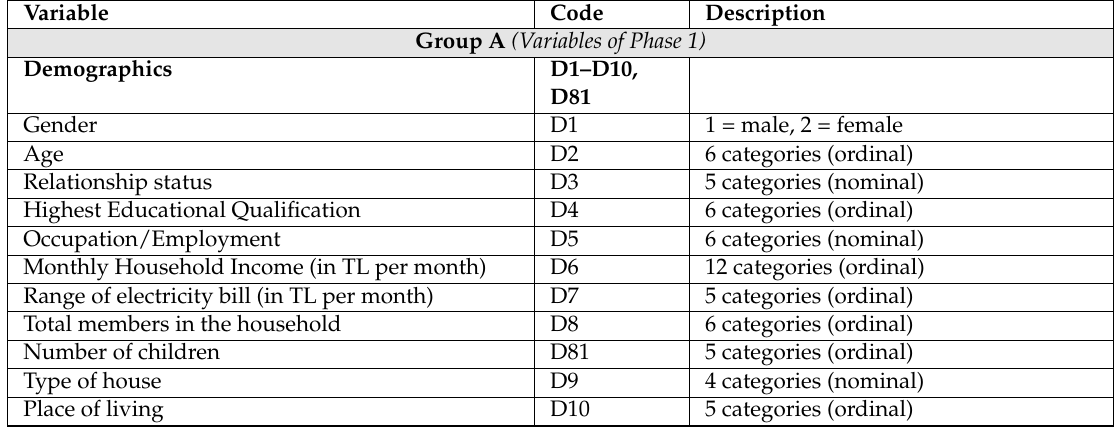
Table A1. Definitions of the variables, coding and description (N =